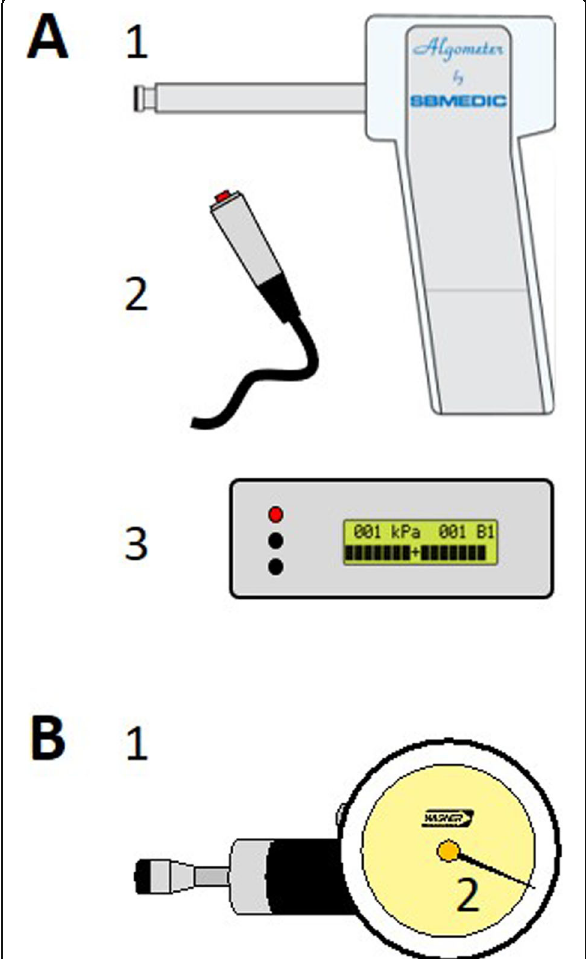
Fig. 1 A Differences Pressure Pain Thresholds digital and analogue algometer Temporalis muscle dominant side in healthy participants. B Differences Pressure Pain Thresholds digital and analogue algometer Temporalis muscle dominant side in people with